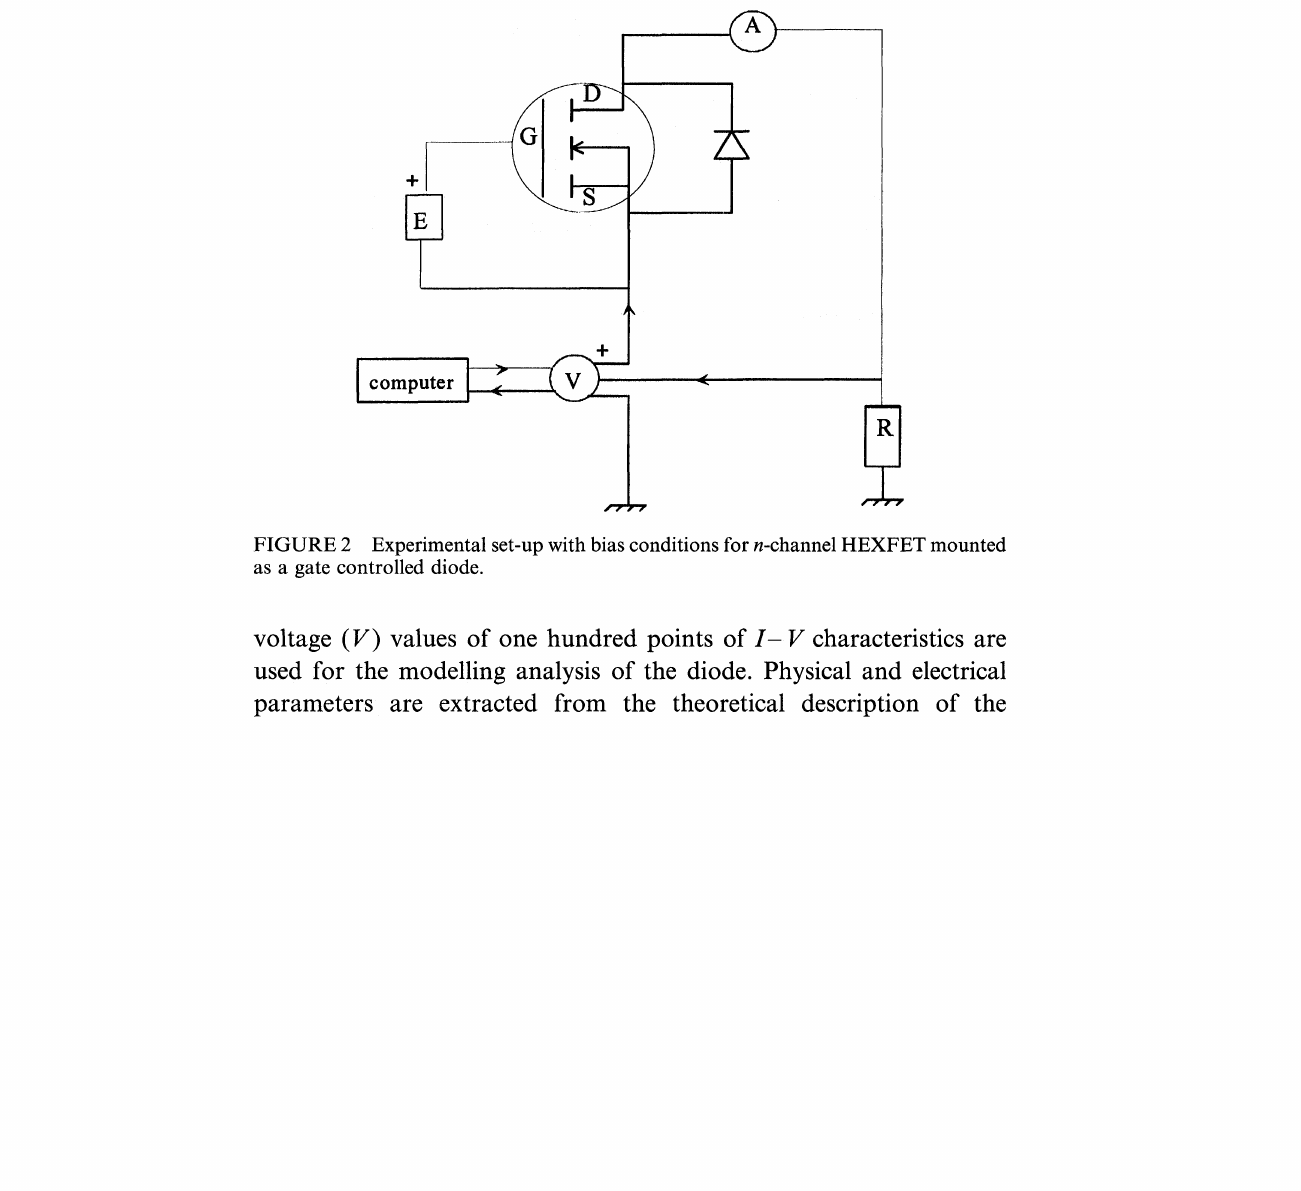
FIGURE The schematic structure of HEXFET showing direct transistor current (DTC) and direct diode (DDC) paths.